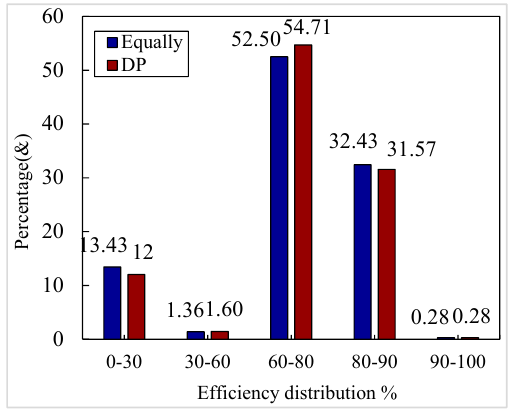
Figure 15. Motor efficiency distribution in HUPDC.